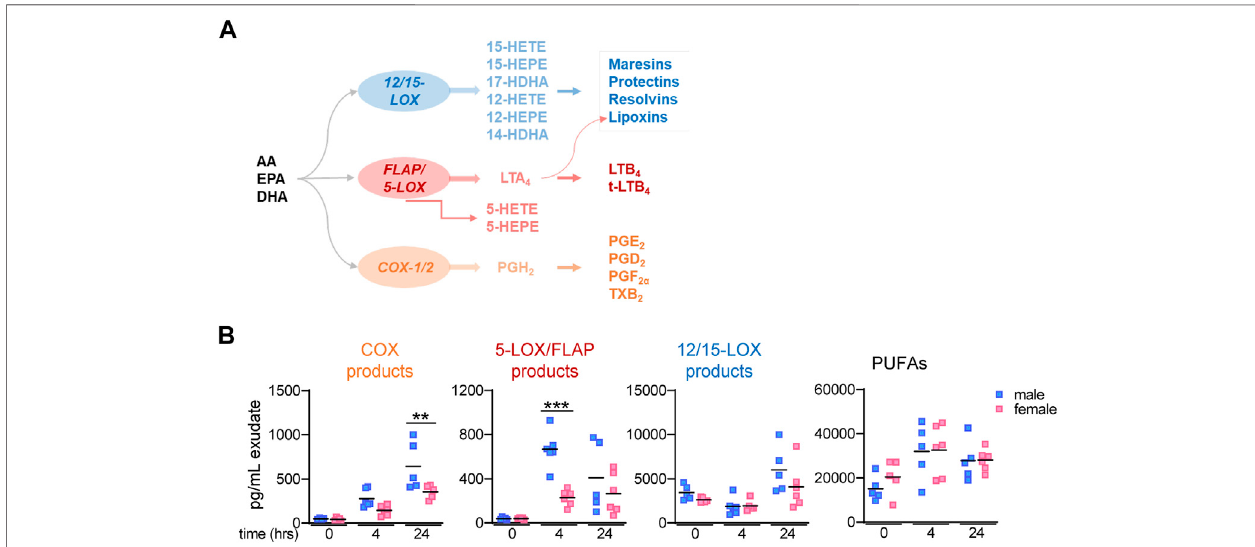
FIGURE 1 | Lipid mediator biosynthetic pathway and lipid mediator levels in mouse peritoneal exudates. (A) Scheme of LM biosynthetic pathways yielding 12/15- LOX – , 5-LOX/FLAP – , and COX-1/2 – derived products and respective enzymes involved. (B) Peritoneal lavages (exudates) from male and female mice were taken at different time points post-zymosan/vehicle i. p. injection. After solid phase extraction, LMs were analyzed by UPLC – MS-MS; time (cid:1) 0 h: peritoneal lavages immediately takenfrommiceaftertreatmentwithvehicle(nozymosan);t (cid:1) 4 handt (cid:1) 24 h:peritoneallavages(exudates)post-zymosan.AmountsofrelevantLMgroupsrelated to respective biosynthetic enzymes: COX products (sum of PGE 2 , PGD 2 , PGF 2 α , and TXB 2 ), 5-LOX products (sum of LTB 4 , t-LTB 4 , 5-HETE, and 5-HEPE), 12/15-LOX products (sum of 12-HETE, 12-HEPE, 14-HDHA, 15-HETE, 15-HEPE, and 17-HDHA), and PUFA (sum of AA, EPA, and DHA). Results are shown in pg/mL exudate in scatter dot plots of individual data points and the mean in black lines; n (cid:1) 5 – 6; *** p < 0.001 male vs. female; two-way ANOVA with Š ídák ’ s multiple comparison test.